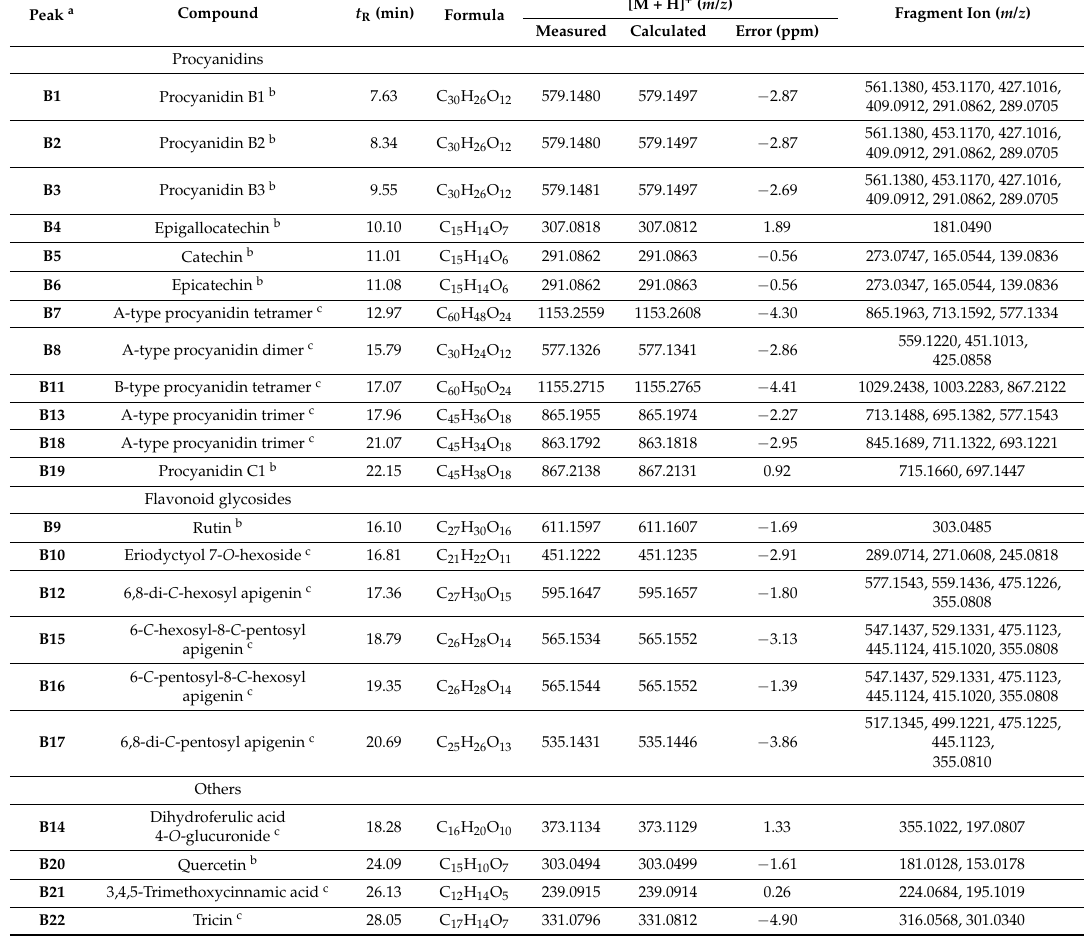
Table 3. Identification of flavonoids and phenolic acids in Fr.